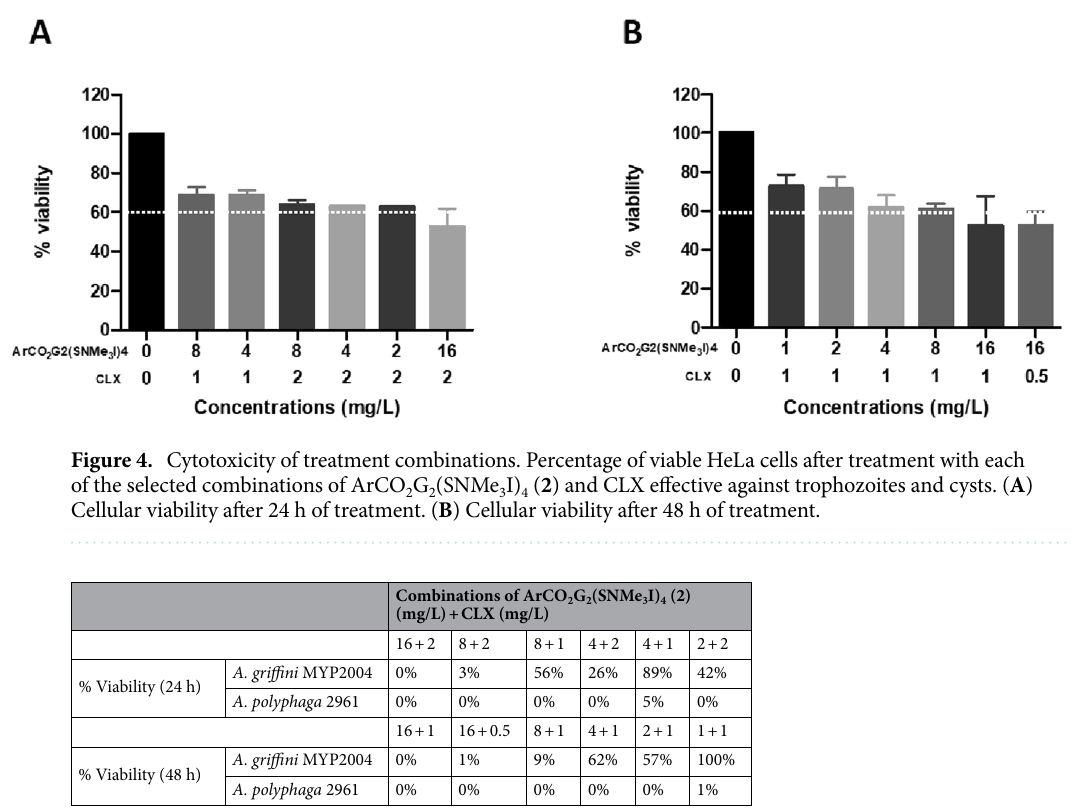
Table 8. Viability (%) in trophozoites of A. griffini MYP2004 and A. polyphaga 2961 after 24 and 48 h of treatment with each of the effective concentrations evaluated in the cytotoxicity